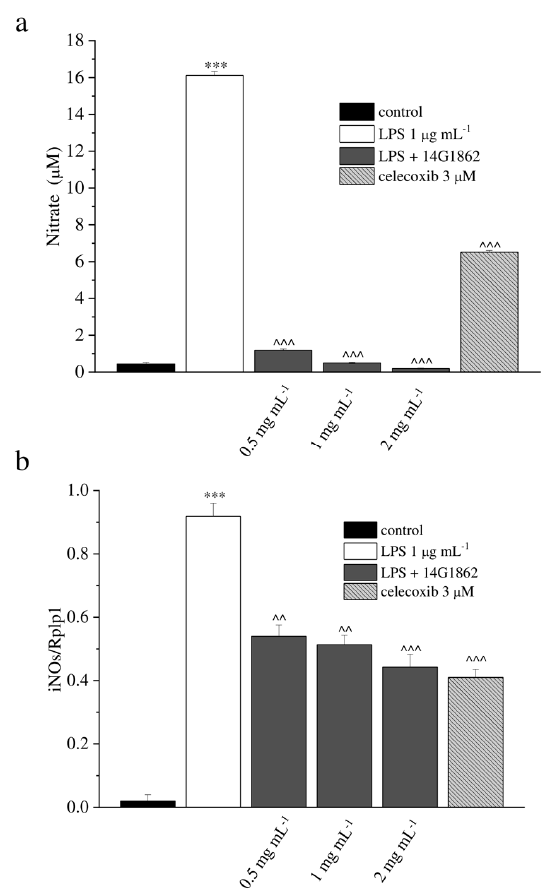
Figure 1. In-vitro antioxidant and anti-inflammatory properties of the system of molecules 14G1862 from Centella asiatica . ( a ) Effect of 14G1862 (0.5–2 mg mL − 1 ), on nitrites production in RAW 264.7 macrophages stimulated with LPS 1 μ g mL − 1 for 18 h in comparison to celecoxib 3 μ M. ( b ) Effect of 14G1862 (0.5–2 mg mL − 1 ), on iNOS mRNA expression in RAW 264.7 macrophages stimulated with LPS 1 μ g m − 1 for 18 h in comparison to celecoxib 3 μ M. Data are expressed as mean ± S.E.M. of three independent experiments. *** p < 0.001 vs. unstimulated control cells; ^ p < 0.001 and ^^^ p < 0.0001 vs LPS-treated cells.